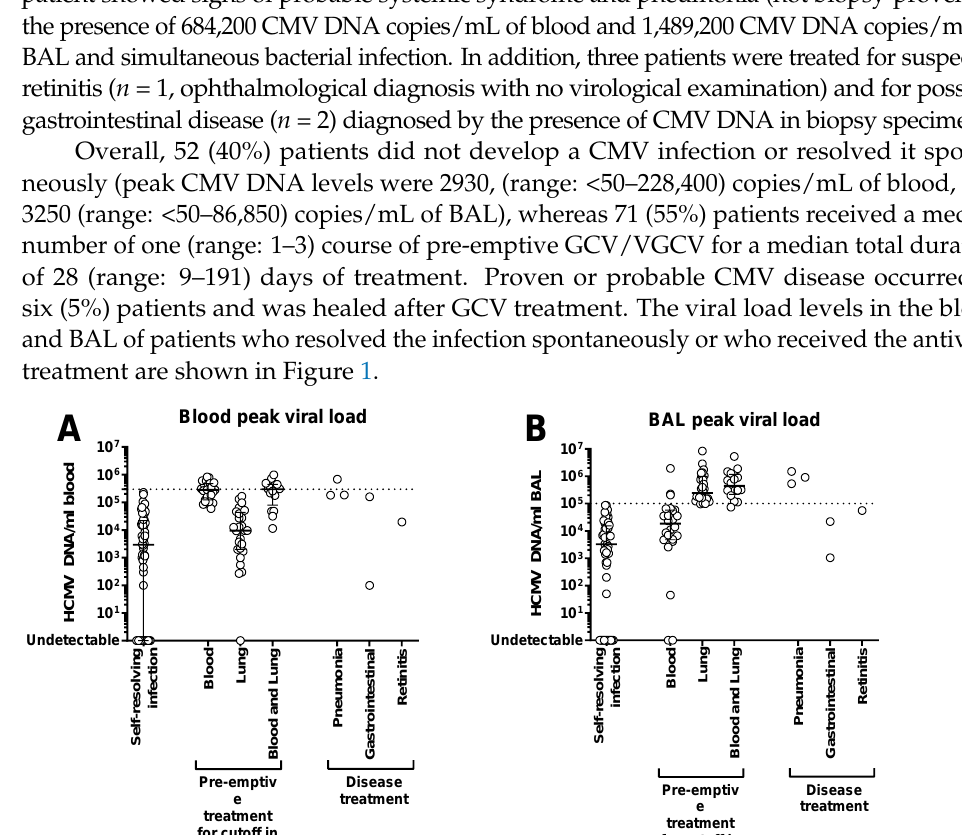
15 Figure 2. Cumulative incidence of CLAD, BOS and RAS . Acute rejection occurred in 69 (53%) patients. As expected, CLAD occurred more fre- quently in patients who experienced acute rejection (Figure 3A), with a 10-year cumula- tive incidence of 63% vs. 26% in patients without acute rejection ( p = 0.013). The potential association between the cumulative incidence of CLAD and the level of CMV infection in the blood and BAL was analysed. The cumulative incidence of CLAD was significantly higher ( p = 0.023) in patients with a high CMV load in the blood (i.e., above the median value) but was not significantly different in patients with a high or low CMV load in the BAL (Figure 3B,C).